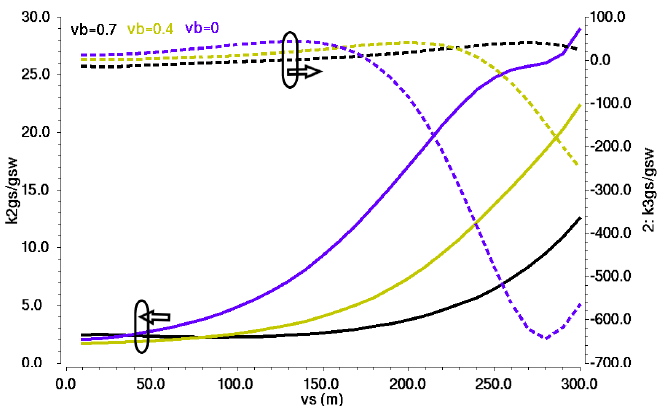
Figure 11. Simulation results of K